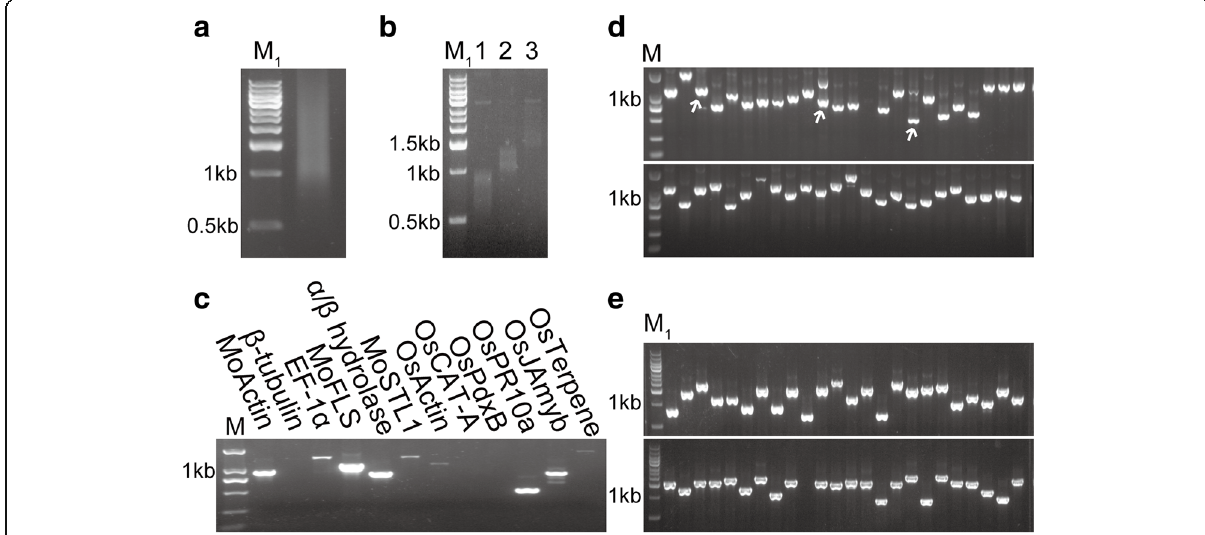
Fig. 4 The PCR assay of the full-length cDNA libraries of upregulated genes. a The PCR amplified inserts from the pTriplEx2 library. Using the library plasmids as template, the insert fragments were amplified by vector-specific primers. b Size fractionation of cDNA inserts. Lanes 1 – 3, different ranges (0.5 – 1 kb, 1 – 1.5 kb, > 1.5 kb) of fractionated cDNA inserts. c Gene-specific analysis. Using plasmids of the expression library I as templates, reference genes were amplified by gene-specific primers. The products were analyzed on 1% agarose gels as indicated. d and e Sizes of the library inserts. Randomly selected 48 colonies from library I ( d ) and II ( e ) were used as templates, and vector-specific primers were used for PCR. The arrows indicate the bands of expected size when two distinct bands appeared. Lane M 1 , DNA ladder (Generay. Code No. 1709G22).